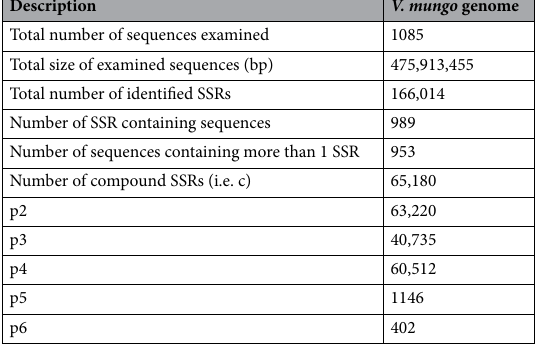
Table 3. Number and distribution of SSRs identified in the blackgram ( Vigna mungo ) cv. Pant U-31